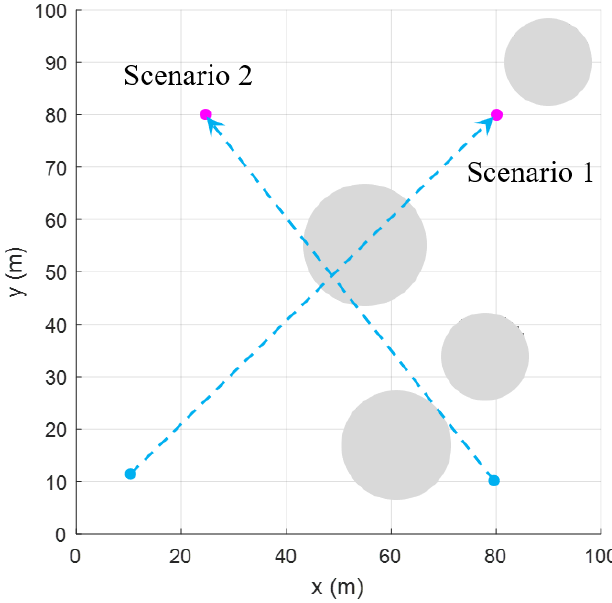
Figure 5. Training scenarios.